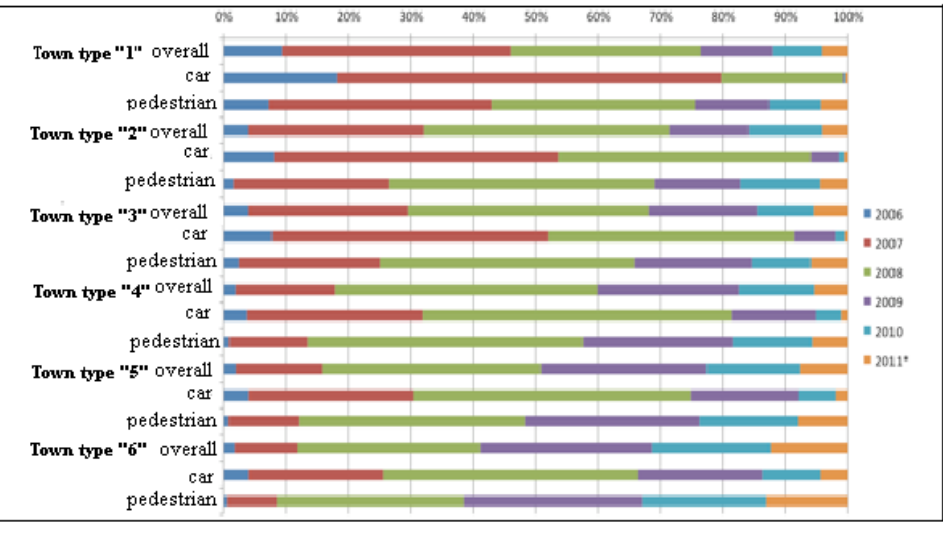
Figure 7. ( a ) Development of OSM Street Network by Town Type; ( b ) Relative Difference by Town Type and Street Network (June